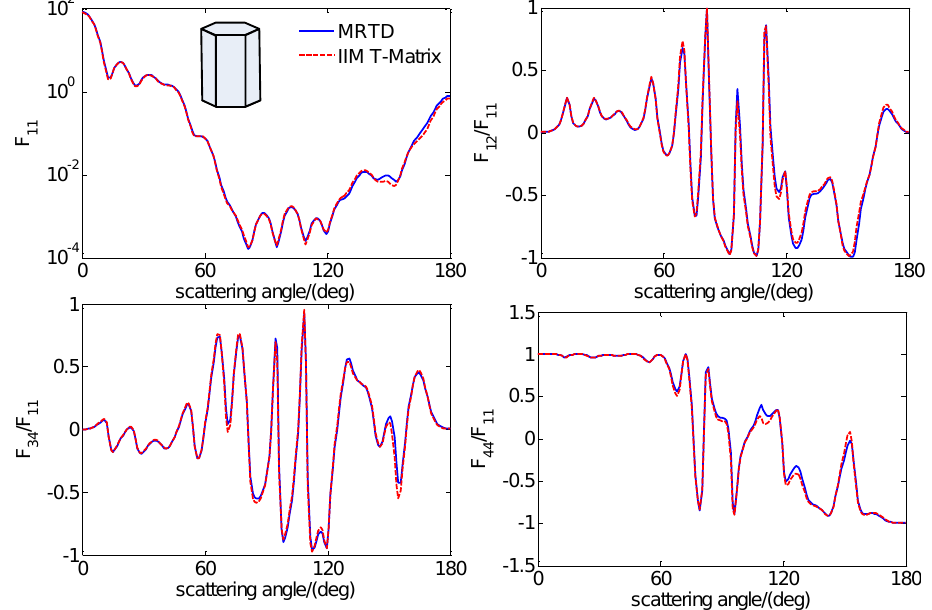
Figure 8. The scattering phase matrix obtained by the IIM T-Matrix method and Multi-Resolution Time Domain (MRTD) for hexagonal prism.